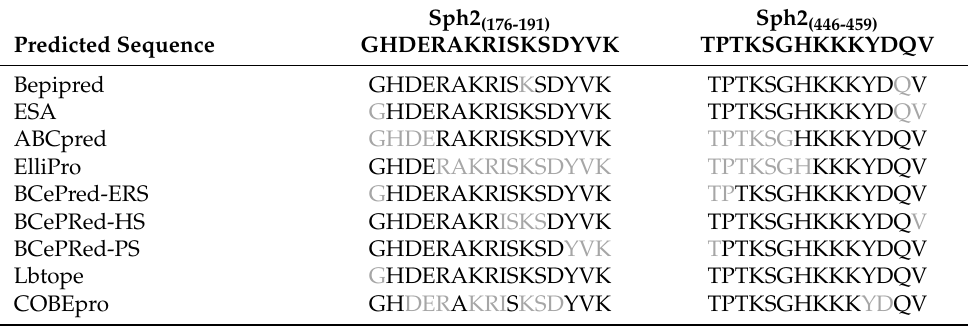
Table 2. Amino acids predicted by each algorithm in Sph2